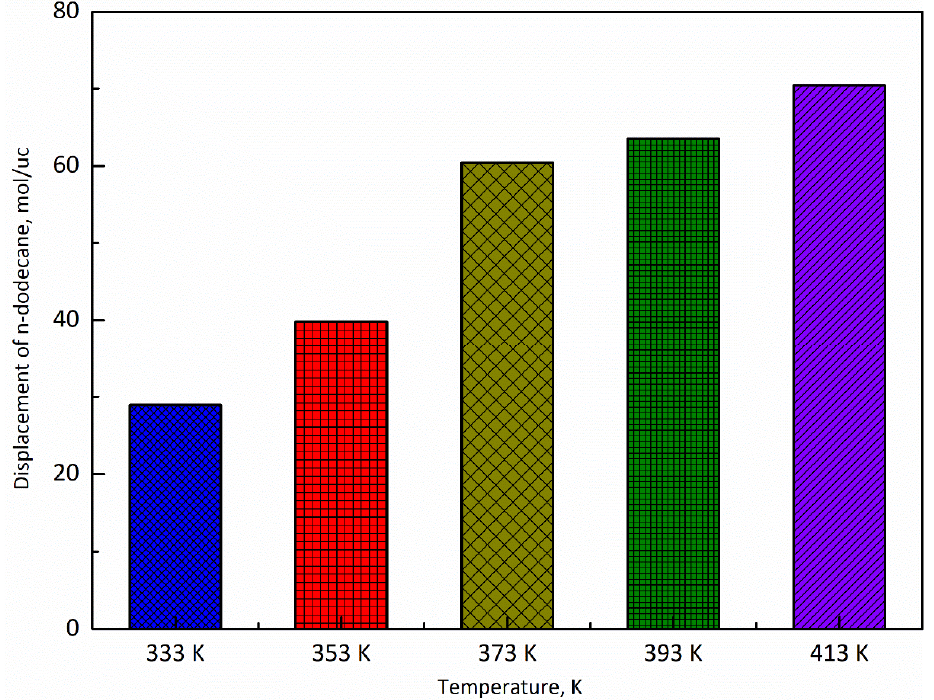
Figure 11. The molar quantity of n-dodecane displaced by CO 2 under different temperature at CO 2 injection pressure of 60 MPa .